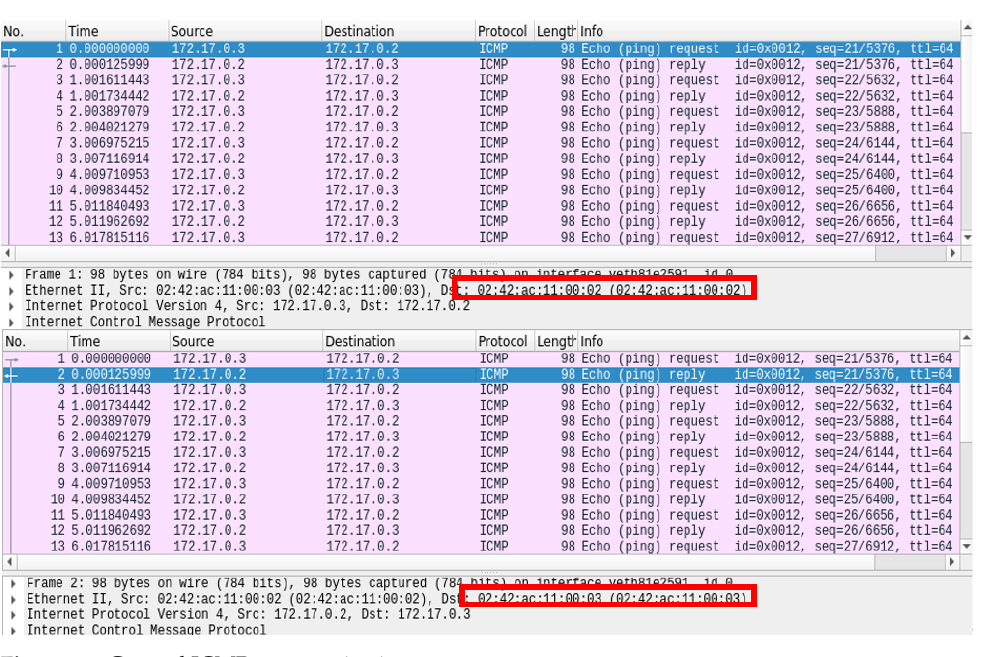
Figure 17. General ICMP communication